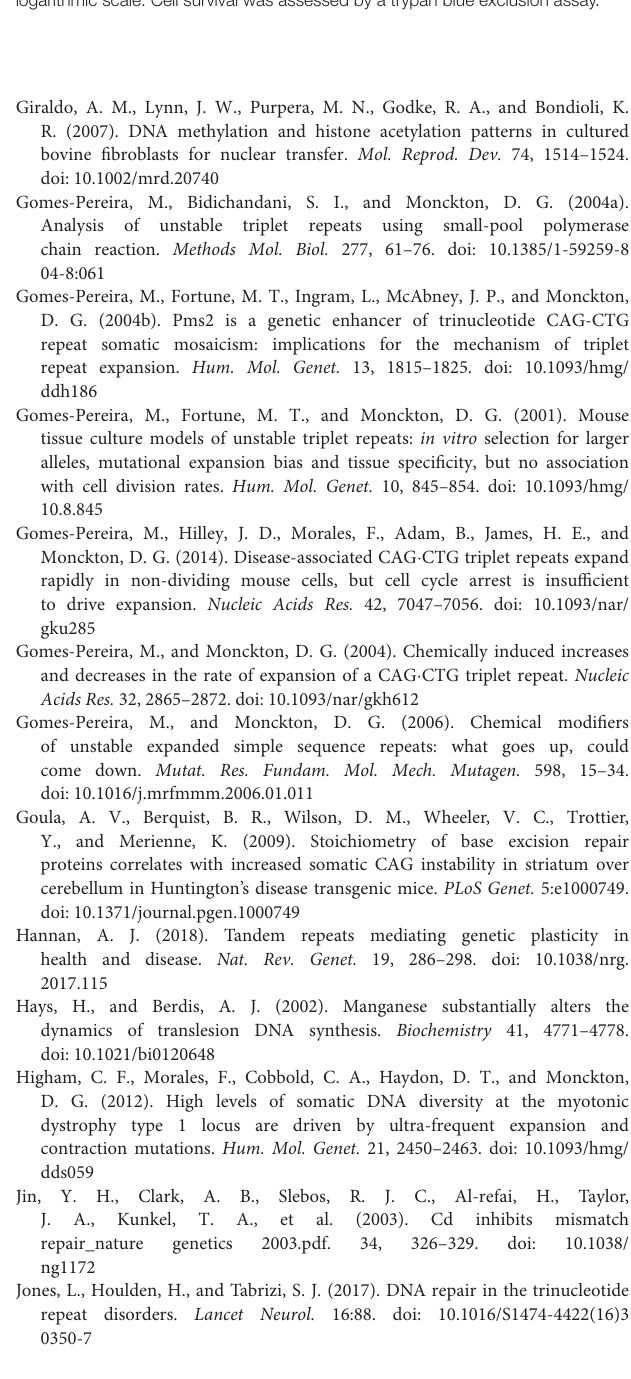
Supplementary Figure 1 | Western blot detection of MMR proteins in D2763Kc2 clones. Uncropped western blots used to prepare Figure 1 . Four protein samples collected from each clone were electrophoresed, electroblotted and probed with anti-MMR proteins. Two antibodies were often combined to detect different proteins simultaneously. ß-Tubulin was used as a loading control.